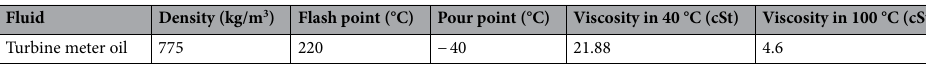
Table 2. Oil characteristics.